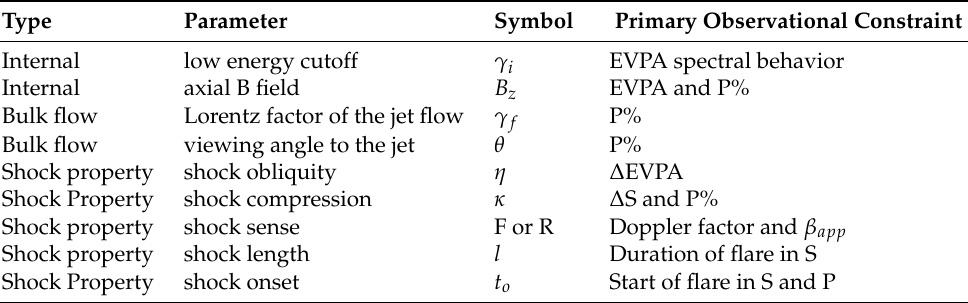
Table 2. Free parameters and UMRAO data used as a model